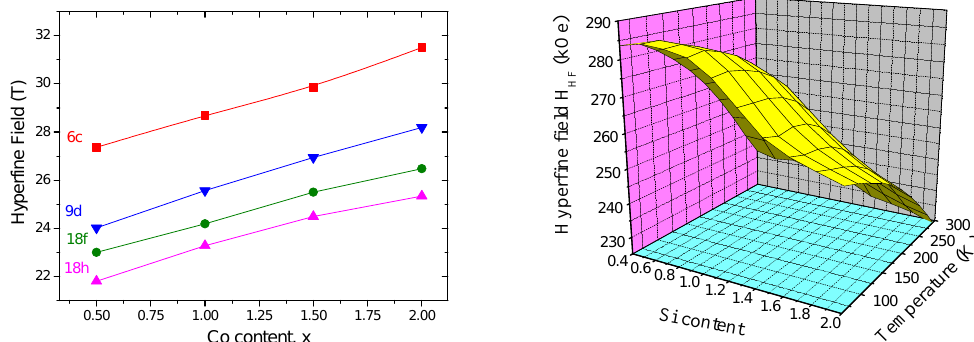
Figure 9. ( Left ) Hyperfine field evolution vs substituted Co atom composition for Sm 2 Fe 17 − x Co x . ( Right ) The dependence of hyperfine field on Si content and temperature for Sm 2 Fe 17 − x Si x